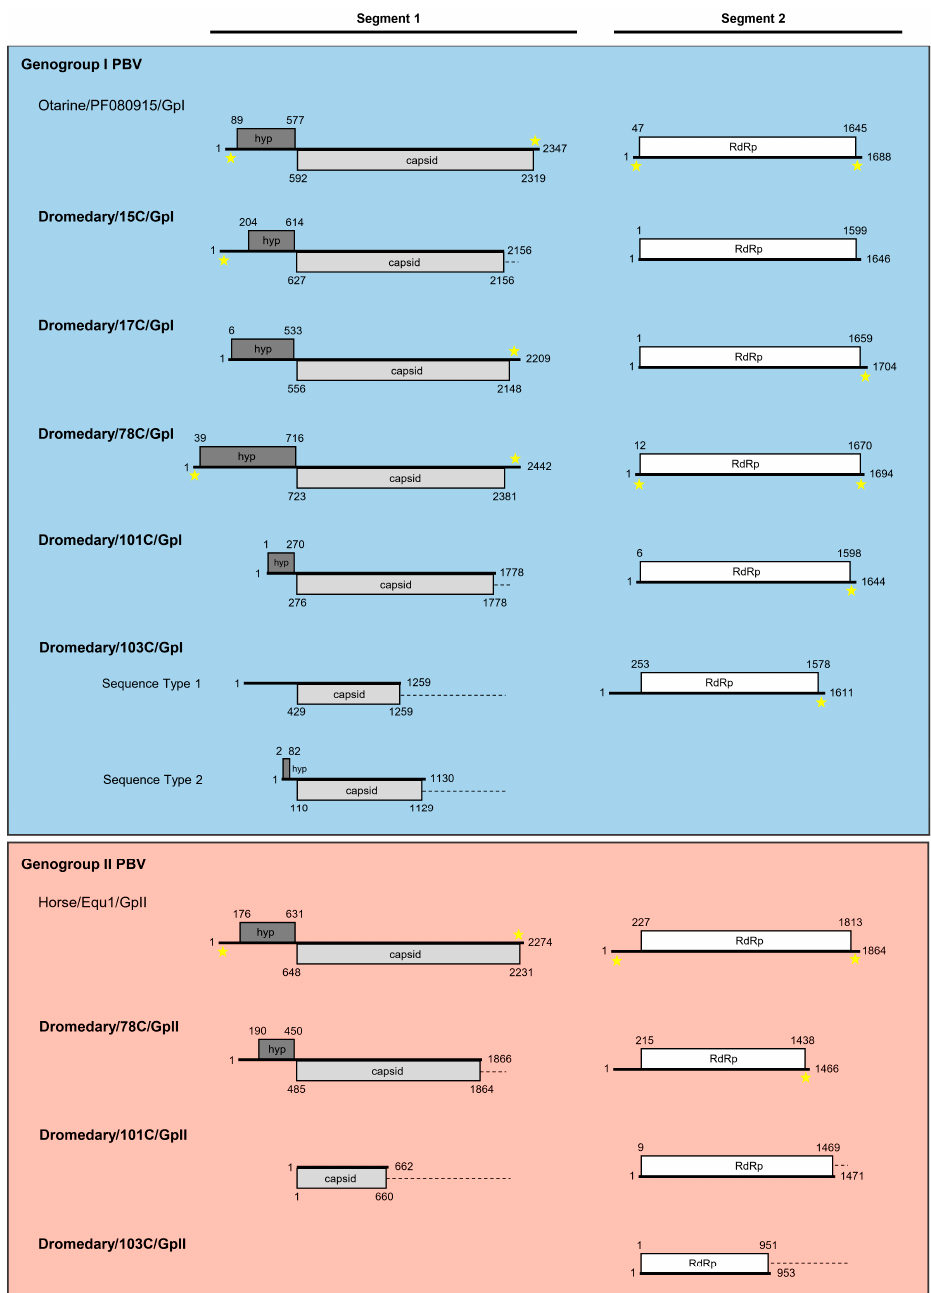
Figure 2. Schematic representation of the gene arrangement of segment 1 and segment 2 of genogroup I (blue box) and II (red box) PBVs sequenced from dromedary fecal samples. Reference sequences are displayed at the top of the corresponding box. The segment 1 sequences in this study encode a capsid protein (light grey box) and an upstream ORF, which encodes a hypothetical protein with unknown function (hyp; dark grey box). The segment 2 sequences encode an RNA-dependent RNA polymerase (RdRp; white box). Stars indicate the presence of conserved bases in the 5 (cid:48) and/or 3 (cid:48) UTRs. Partial sequences have dashed lines at the end, indicating the absence of a stop codon. Numbers indicate the position and lengths of the ORFs.